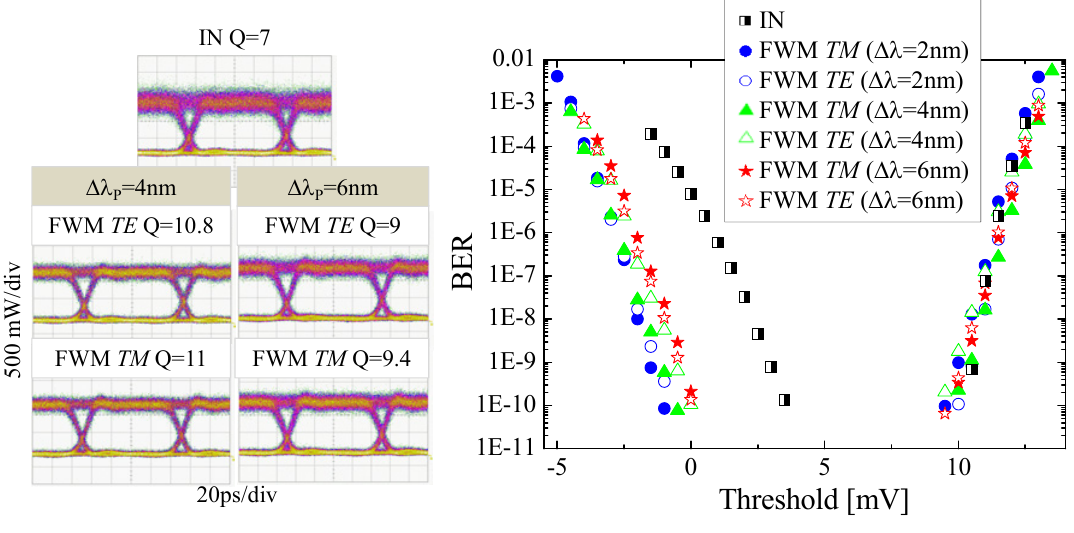
Figure 4. ( left ) Eye diagrams and measured Q-factors of the input (IN), FWM when input is polarized TE (FWM TE ), and FWM when input is polarized TM (FWM TM ) signals for = 4 and 6 nm; ( right ) BER vs. voltage threshold measurements for the input (IN), ∆λ P FWM when input is polarized TE (FWM TE ), and FWM when input is polarized TM (FWM TM ) signals for different values of the conversion span ∆λ